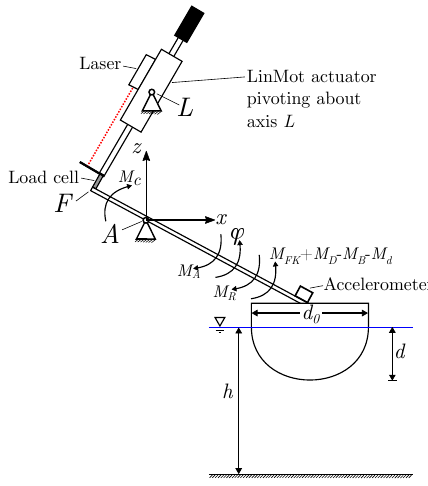
Figure 1. Sketch of the physical model of one buoy